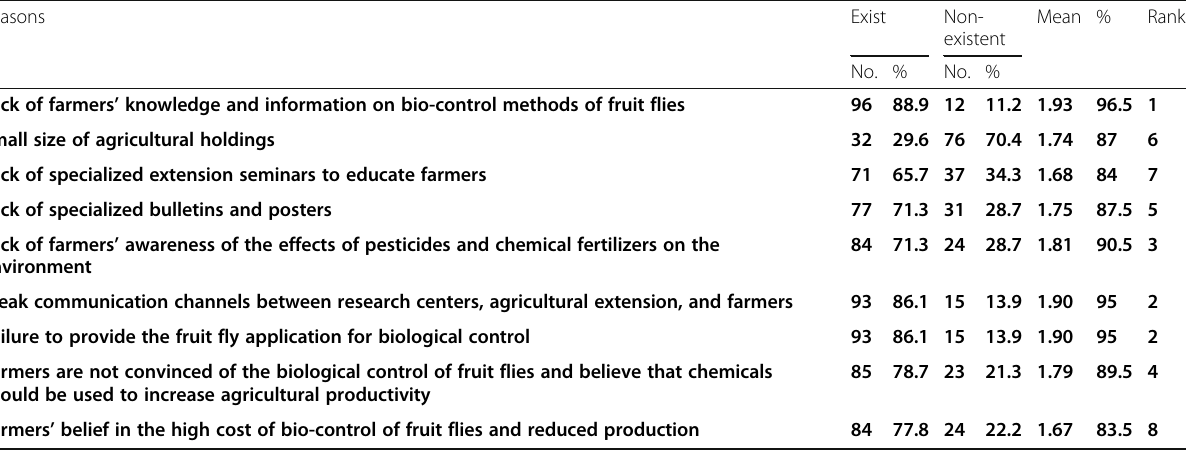
Table 7 Distribution of the researched guides according to the reasons the farmers are reluctant to apply the pest control methods of the fruit fly from their point of view